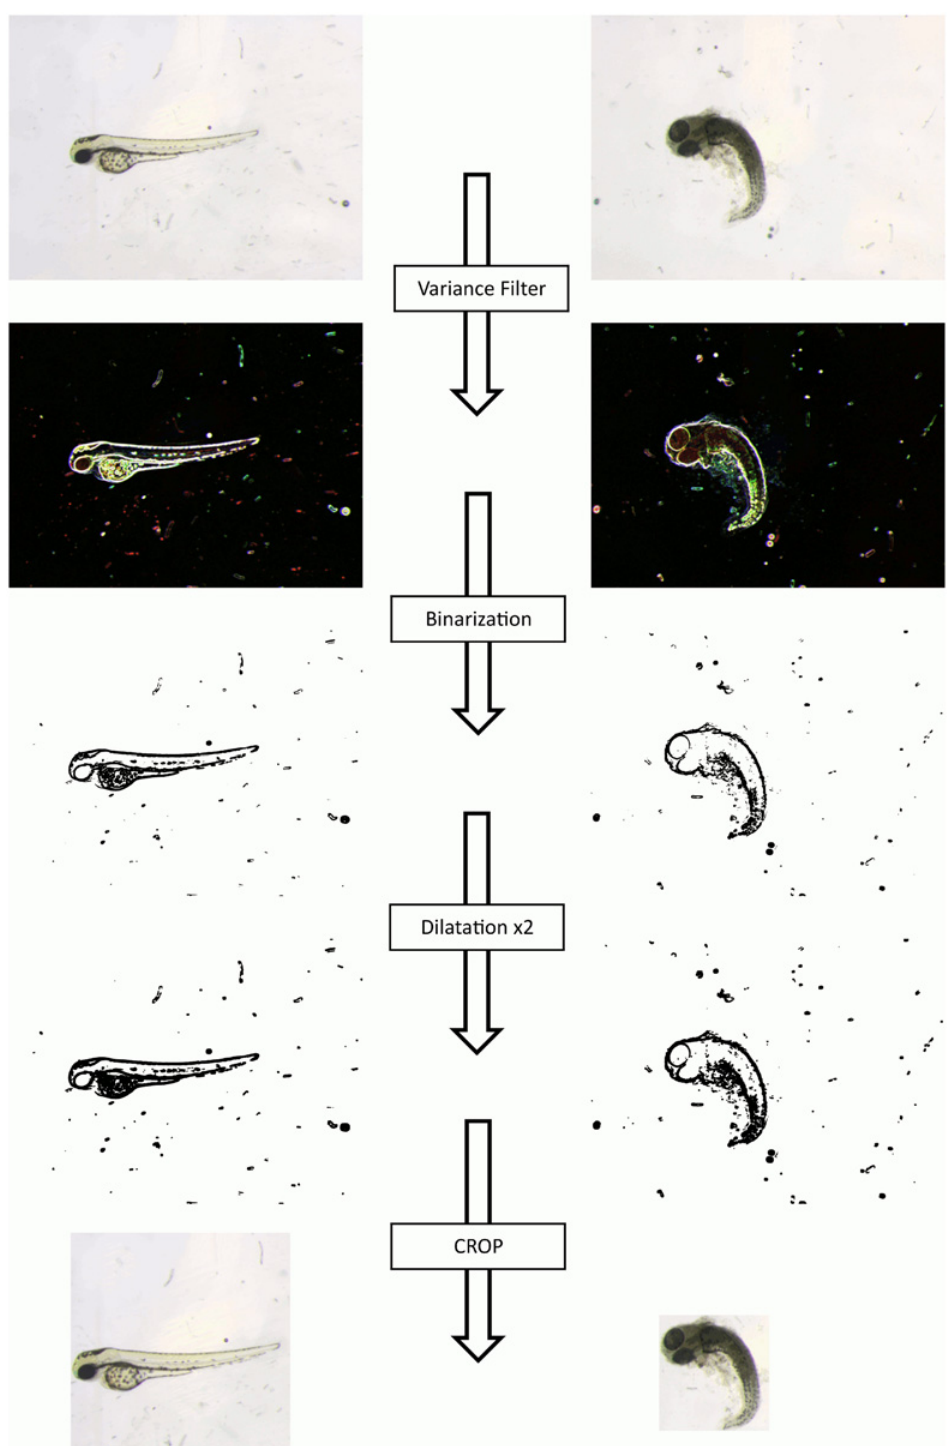
Figure 1. Image Preprocessing: From original image to the one used for classification. The original image is submitted to an ImageJ script ( S1 Fig. for the code) which allows to automatically crop the zebrafish embryo into a square as far as possible. The embryo will be surrounded by a rectangle if it is placed near the sides of the original image. We use a connected-component labeling approach combined with different morphological transformations and binarizations, in order to localize the embryo.